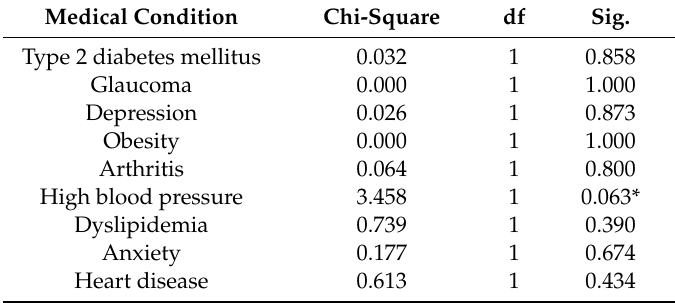
Table 6. Chi-square data and significance values for type 2 diabetes mellitus, glaucoma, depression, obesity, arthritis, hypertension, dyslipidemia, anxiety, and heart disease. Medical Condition Chi-Square df Sig. Type 2 diabetes mellitus